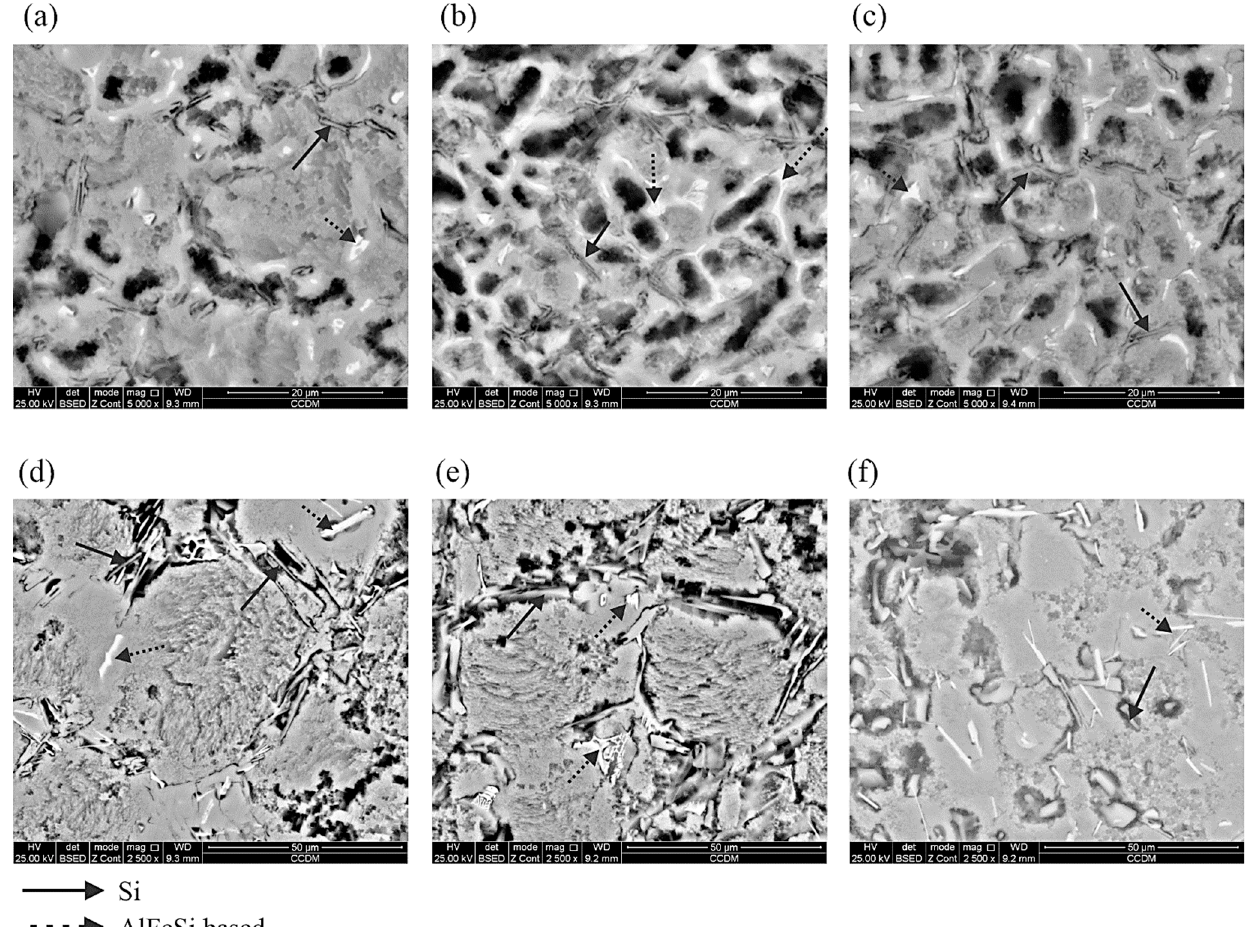
Figure 5. SEM images after potentiodynamic polarization tests for smaller SDAS samples of the ( a ) Al-7%Si-0.6%Fe-0.35%Cu-0.25%Zn, ( b ) Al-7%Si-0.6%Fe-0.35%Cu-0.25%Zn-0.5%Ni and ( c ) Al-7%Si-0.6%Fe-0.35%Cu-0.25%Zn-0.5%Co alloys; and for larger SDAS samples of the ( d ) Al-7%Si-0.6%Fe-0.35%Cu-0.25%Zn, ( e ) Al-7%Si-0.6%Fe-0.35%Cu-0.25%Zn-0.5%Ni and ( f ) Al-7%Si-0.6%Fe-0.35%Cu-0.25%Zn-0.5%Co alloys.